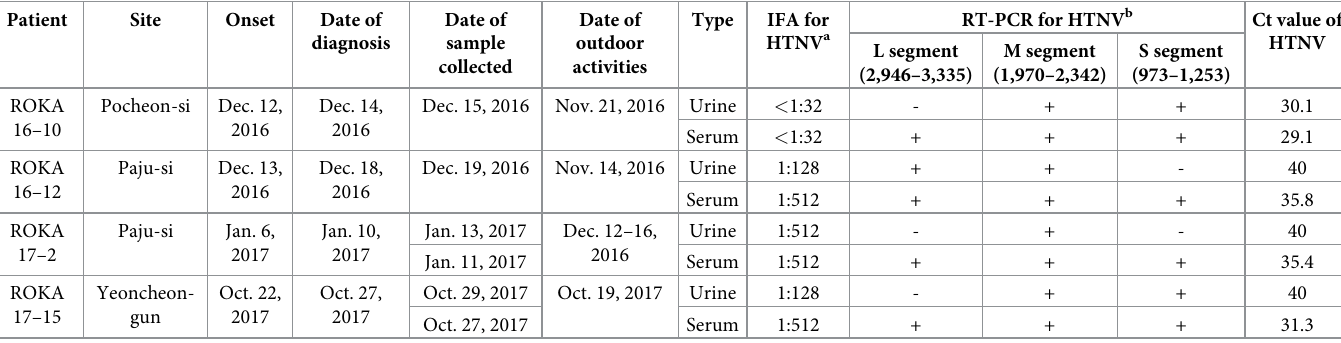
Table 1. Summary of Republic of Korea Army (ROKA) with hemorrhagic fever with renal syndrome (HFRS) patient information. Patient